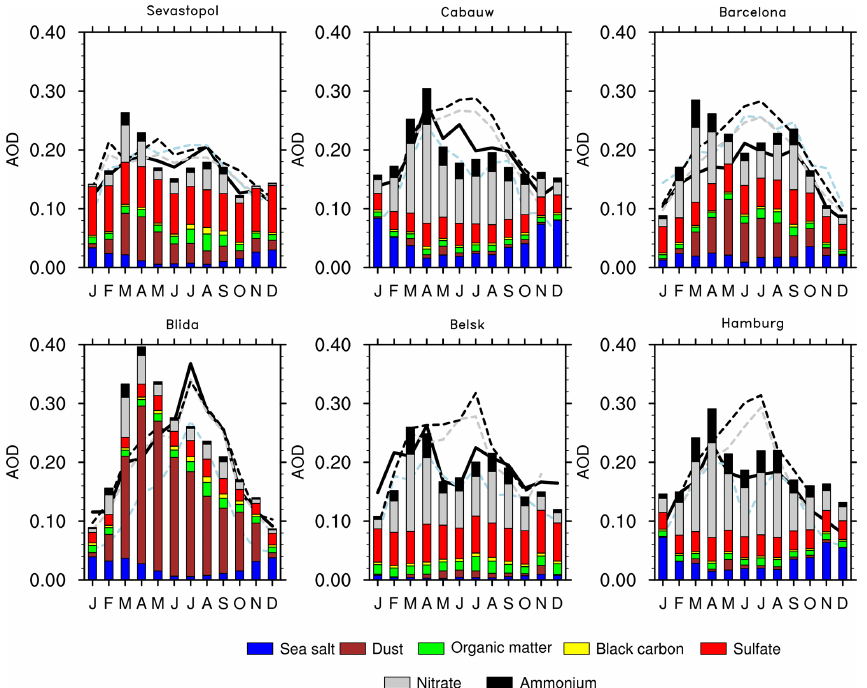
Figure 5. Comparison of the average annual cycle (2003–2012) of aerosol optical depth (at 550nm) simulated by the ALADIN-Climate model (bars), with measurements at six selected AERONET stations (black line) and measurements by MISR (light blue dotted line), MODIS Aqua (grey dotted line) and MODIS Terra (black dotted line). The model contribution of each aerosol type is indicated using different colour